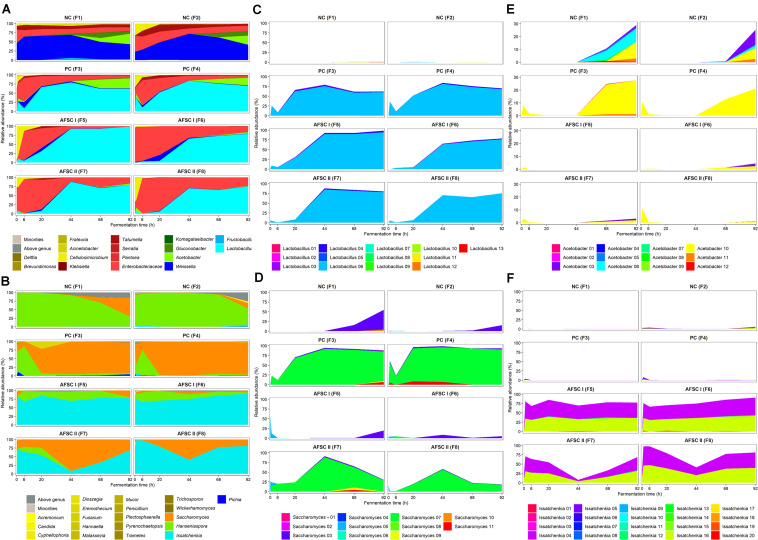
Microbial community and species dynamics, expressed as relative abundances based on the amplicon sequence variants (ASVs) of the V4 region of the 16S rRNA gene for bacteria (A) and the internal transcribed spacer (ITS) region ITS1 of the rRNA transcribed unit for yeasts (B) during 92 h Costa Rican cocoa fermentation processes carried out in eight different vessels. The type of fermentation process (F1–F8) and sampling are as explained in the legend of Figure 1. Microbial groups with relative abundances below 0.5% are represented in the category ‘Minorities.’ ASVs that could not be allocated to genus level are represented in the category ‘Above genus.’ The Enterobacteriaceae family is indicated separately. Starter culture growth monitoring allocated the ASVs to specific strains of the genera Lactobacillus
(C), Saccharomyces
(D), Acetobacter
(E), and Issatchenkia
(F).